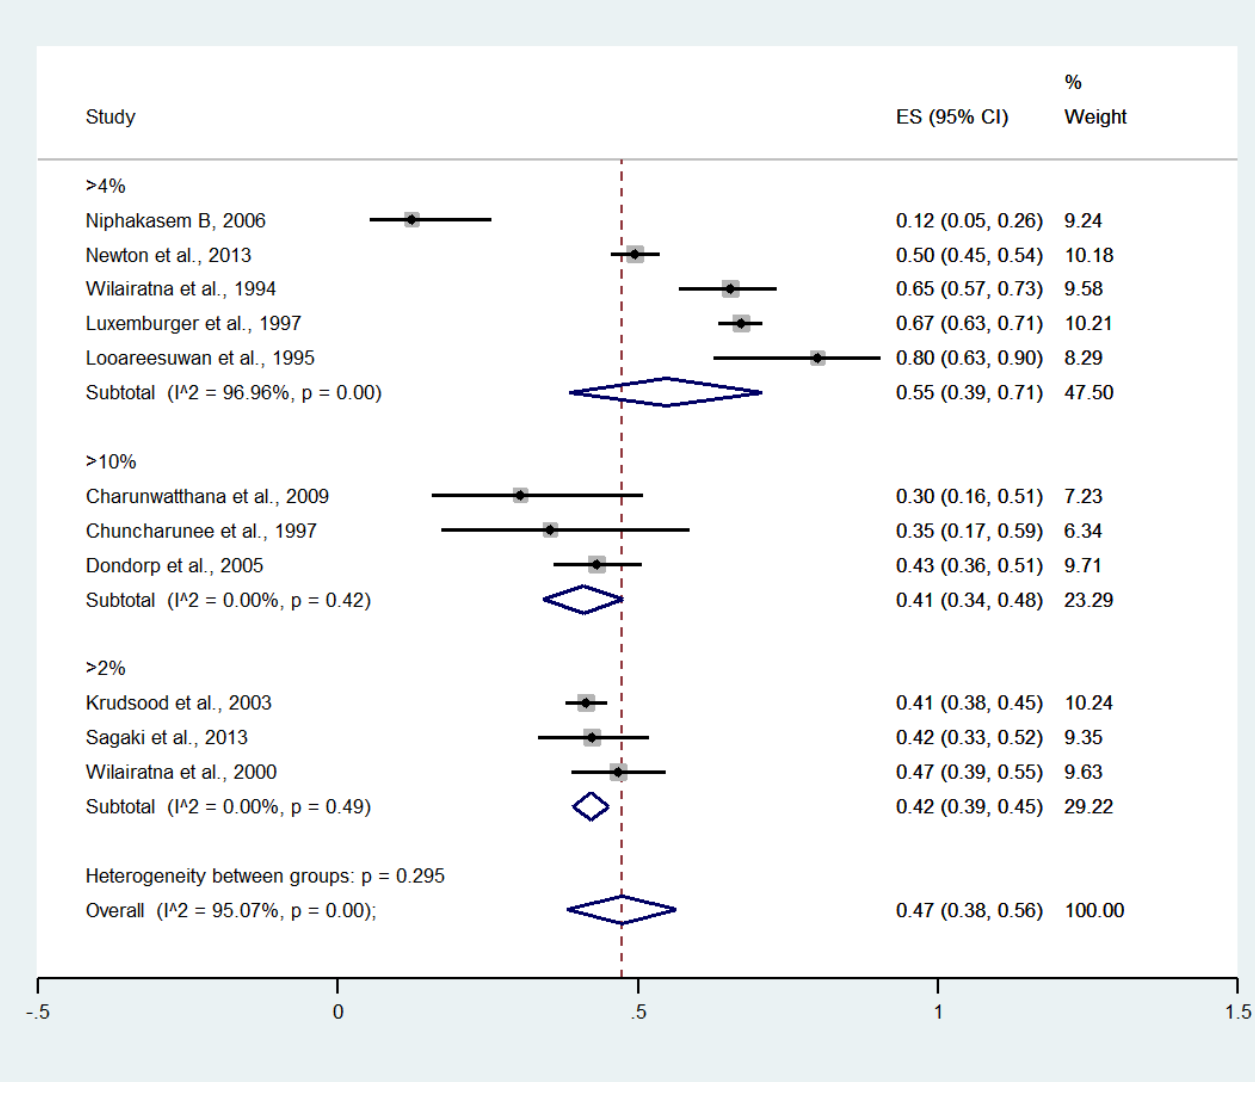
Figure 5. The pooled prevalence of hyperparasitemia among patients with severe malaria in Thailand at different cutoffs. The label for the x-axis is the scale of estimated prevalence. Abbreviations; ES, estimated prevalence; CI, confidence interval .